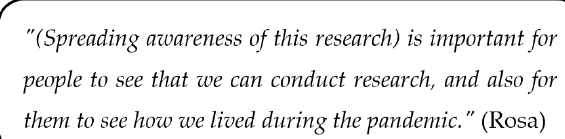
Figure 6. Co-researcher’s opinion 11.